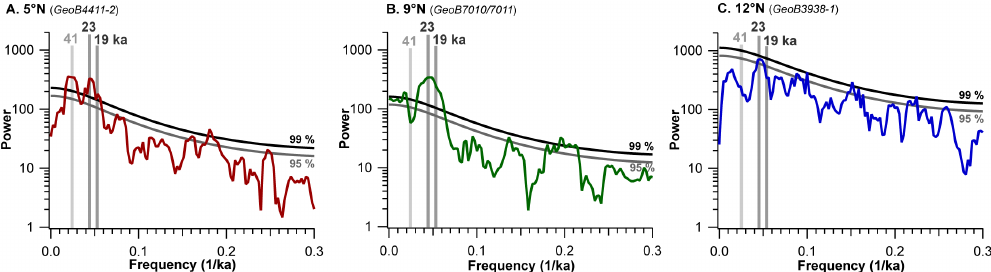
Fig. 7. Multitaper method (MTM) spectral analysis (Ghil et al., 2002) (number of tapers 3; bandwidth parameter 2) of detrended %-Andes records for sites at (A) . 5 ◦ N: GeoB4411-2, (B) 9 ◦ N: GeoB7010/7011, and of the detrended %-Amazon record for the site at (C) . 12 ◦ N: GeoB3938-1. 95% (grey line) and 99% (black line) significance levels are shown and the main statistically significant peaks (periods in ka) are indicated. Vertical bars highlight the position of the 1/41 (light grey), 1/23 and 1/19ka − 1 (dark grey)